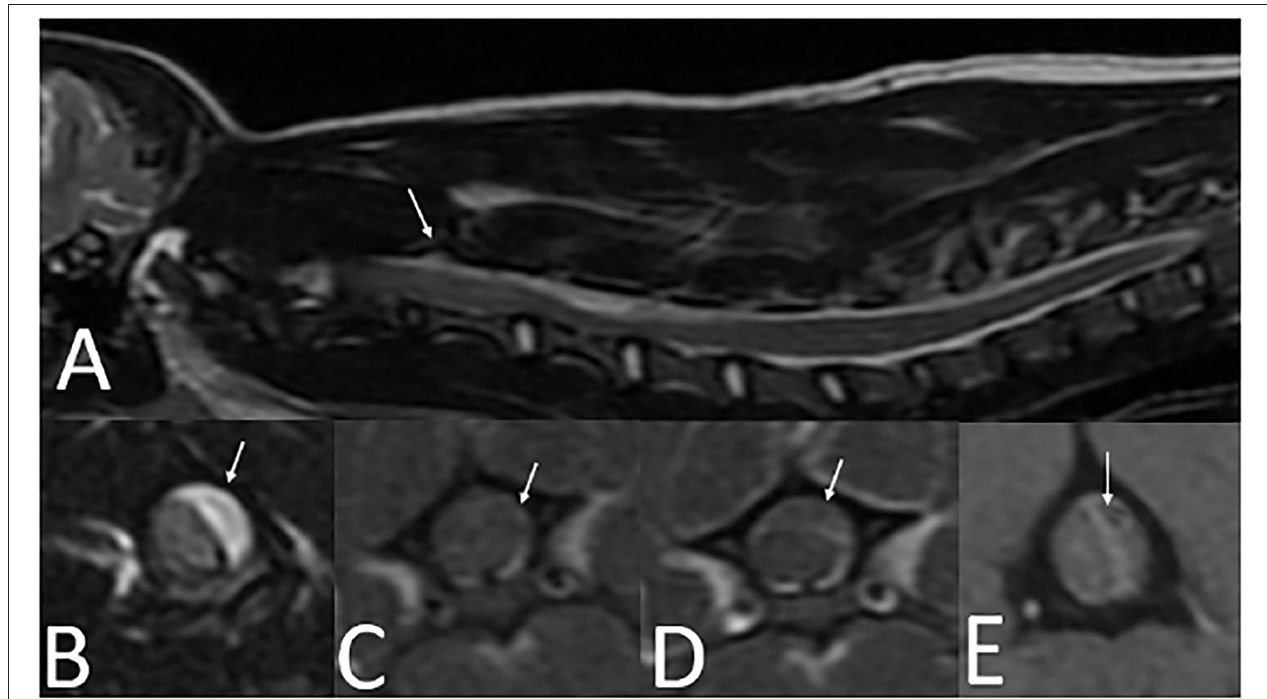
FIGURE 4 | Cervical MRI in a 5-month-old 2.5kg sexually intact male Yorkshire Terrier with an acute onset of cervical pain (case three). (A) —T2W sagittal image of the cervical spine with longitudinal T2 hyperintensity extending from C2-C6 (arrow). (B) —T2W transverse image at the level of C4 showing T2 hyperintense extradural material resulting in severe spinal cord compression (arrow). (C) —T1W pre-contrast transverse image at the level of C4 showing T1 iso- to hypointense extradural material resulting in severe spinal cord compression (arrow). (D) —T1W post-contrast image at the level of C4 showing minimal contrast enhancement along the rim of the extradural material (arrow). (E) —T2* image at the level of C4 with heterogenously hyperintense extradural material in the left dorsolateral vertebral canal. A susceptibility artifact is present